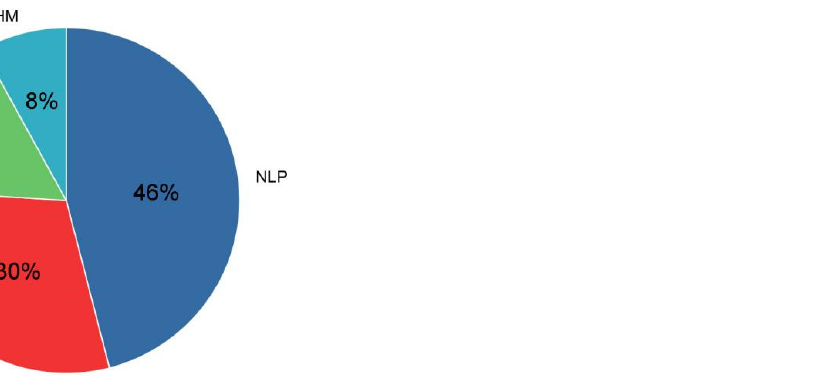
Figure 1. Recovery of vision in TON patients after surgery. NLP: No light perception; LP: Light perception; HM: Hand movement; FC: Finger counting.